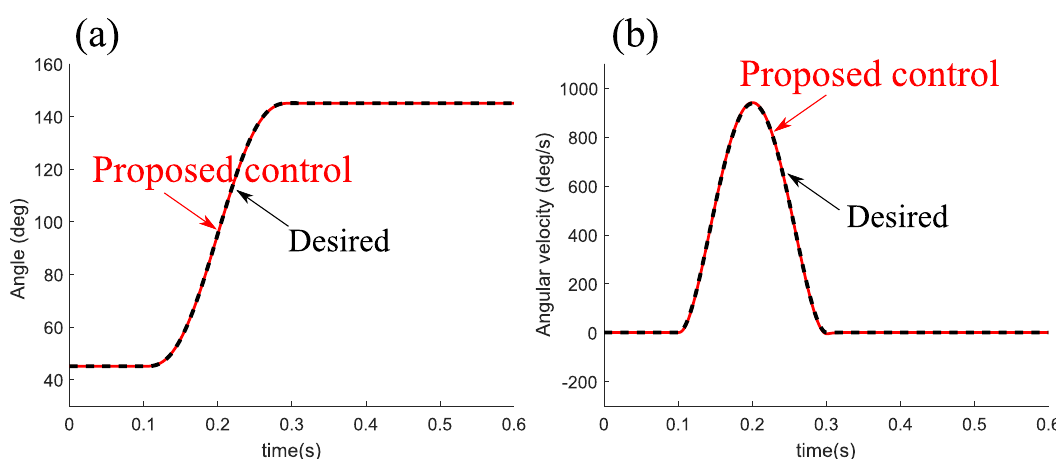
Fig 7. Simulated fast movement with a delay of 300 ms. The position and velocity profiles of a fast movement are produced under a delay of 300 ms, with the gain values remaining the same as the fast movement under a delay of 65 ms. The proposed control follows the minimum-jerk trajectory with the increased